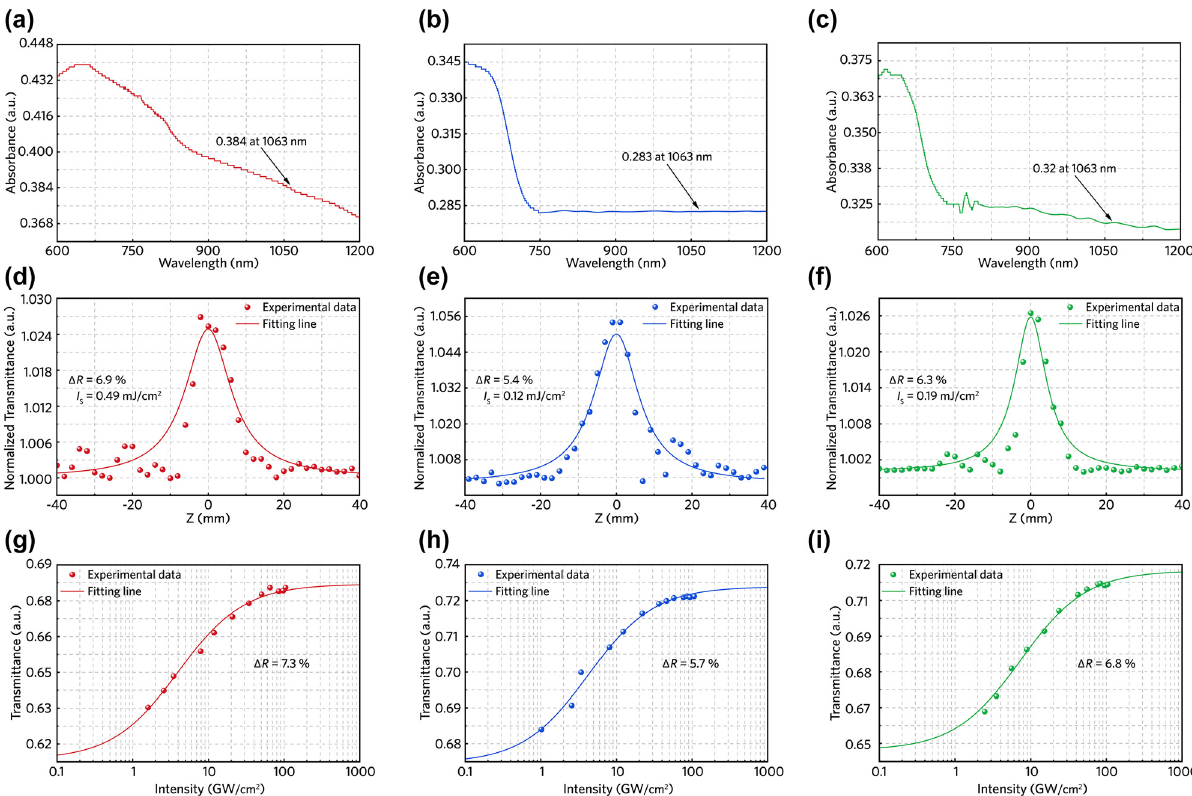
Figure 4: Linear and nonlinear optical properties. (a)–(c) Optical absorption spectrums of HfSe based SAs under 1035-nm laser excitation (g)–(i) The intensity dependent nonlinear transmittances of few-layer HfSe nanosheets at 1035